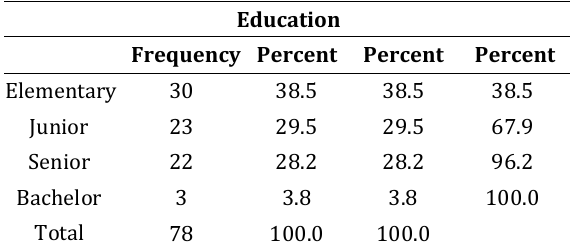
Table 2. Distribution of respondents by education in Class II A in Kediri City